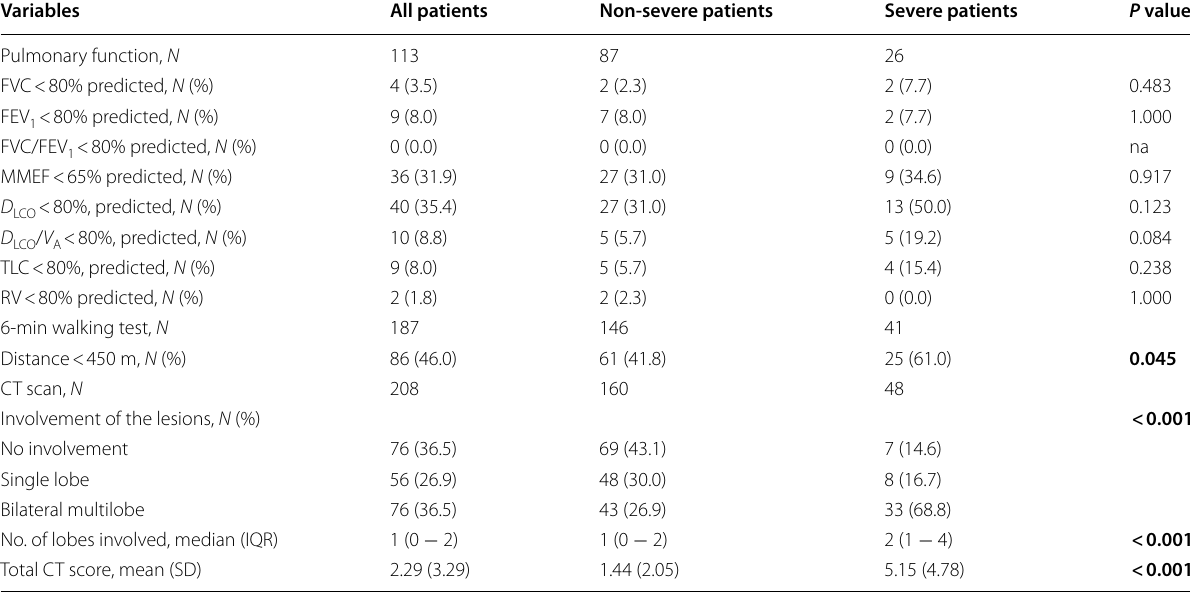
Table 2 Pulmonary function test, 6-min walking test, and CT scan at 1-year